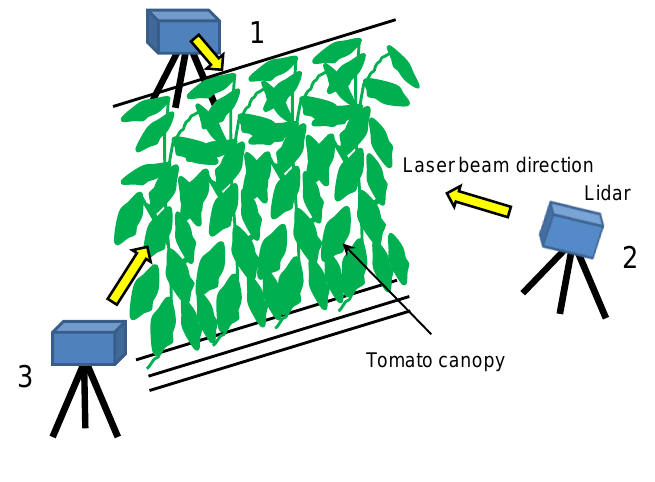
Figure 2. A schematic view of the tomato canopy measurement by the portable scanning lidar. Arrows show the directions corresponding to the center of laser beam scan from each of the measurement positions of 1 to